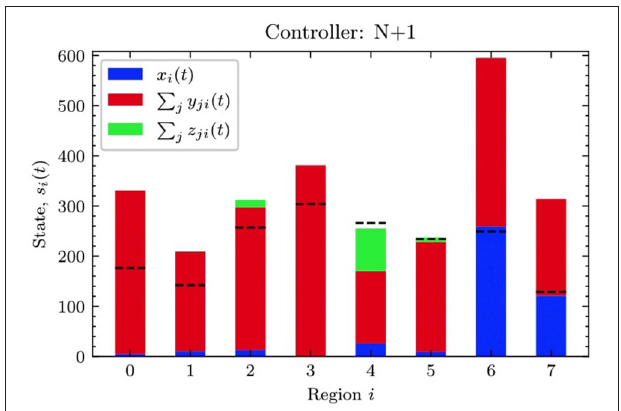
FIGURE 2 | A diagram of the state of the system for the EMA network. Every bar in the plot represents the state of a region composed of the available vehicles (blue), the en-route customer-carrying vehicles (red), and the empty rebalancing vehicles (green). The dotted line represent the parameter θ i for every region i which indicates the minimum desired level to be satisfied when performing a rebalancing